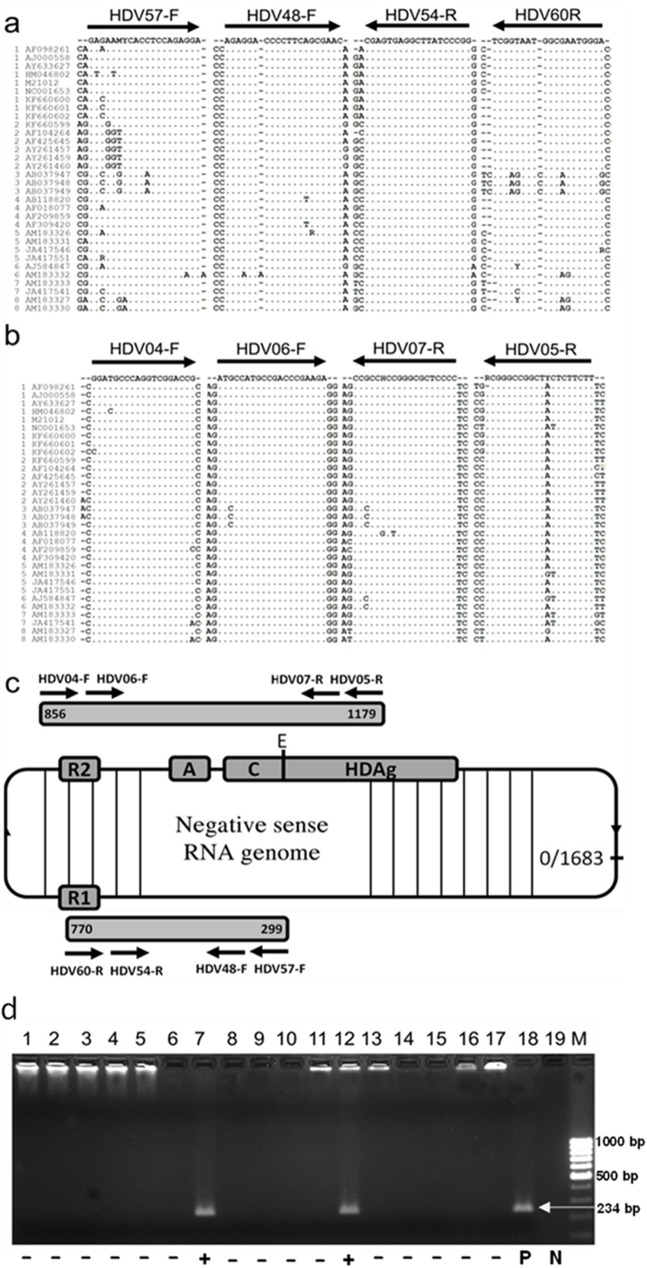
Nested HDV specific RT-PCR.(a) Primers for HDV-specific nested PCRs were selected in highly conserved regions of the HDV genome. For detecting HDV RNA genomes, primers HDV57-F and HDV60-R were used for first PCR round, HDV48-F and HDV54-R were used for nested PCR [34]. (b) For HDV genotyping, primers HDV04-F and HDV05-R were used for the first round, primers HDV06-F and HDV07-R were used for nested PCR [31]. The primers matched with reference sequences of eight prototype HDV genotypes retrieved from the NCBI-GenBank. The primer sequences target to two different regions of the HDV genome. The numbers 1 to 8 in (a) and (b) of each reference sequence indicate the respective HDV genotypes 1 to 8. (c) Schematic representation of the HDV genome and primer binding sites. R1, R2 = ribozyme domain; C = C-terminal amino acid extension; A = PolyA. HDAg: hepatitis delta antigen; E = RNA editing site (position at nt 1015) [38]. Numbering is according to HDV strain NC1001653. (d) Representative agarose gel electrophoresis of amplified HDV products from nested-PCR using primers indicated in Fig 1B. The final PCR product length is 234 bp. HDV positive samples were identified in lanes 7 and 12. P, positive control was amplified from a full-length HDV plasmid (lane 18). N, negative control (lane 19). M, marker.